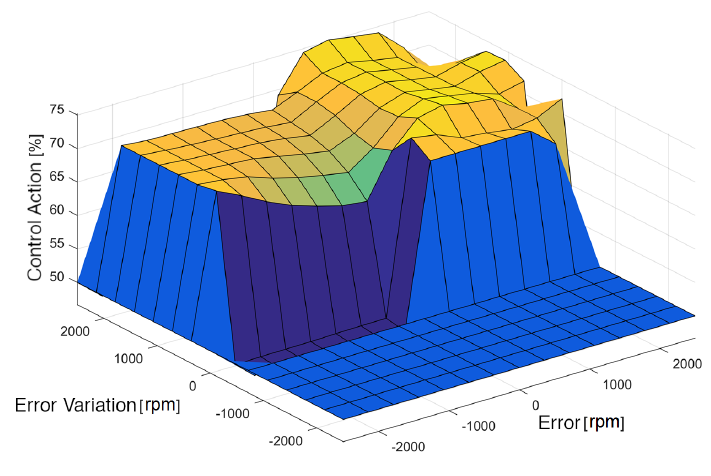
Figure 11. Fuzzy response surface.